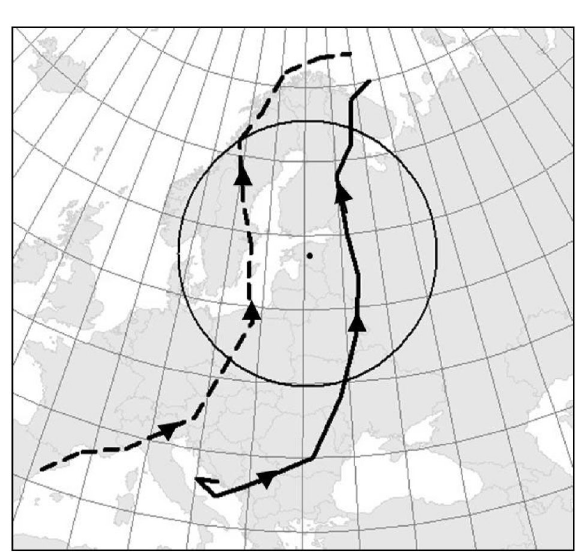
Fig. 1. Map of Europe showing the circle of 1000 km radius with its centre in Estonia at 58.75(cid:176)N and 25.5(cid:176)E, and the example trajectories of the two classes of southern cyclones: from south to northwest of Estonia (19(cid:150)20 August 1948, dashed line) and from south to northeast of Estonia (28 January(cid:150)1 February 2004, solid line).